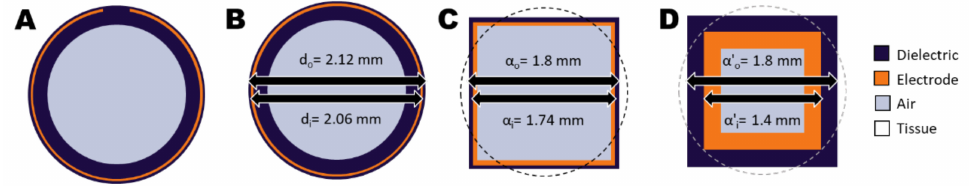
Figure 2. Cross-sections of the ThermoBrachy applicator show the geometric simplification steps applied in this study. ( A ) The actual cross-section of the thermobrachy electrode. ( B ) The electrode can be closely approximated by a cylindrical electrode equivalent. ( C ) The cylindrical applicator can be closely approximated by an orthogonal equivalent with equal outer surfaces for the electrode and dielectric layers. ( D ) The dimensions of the orthogonal layers can be adapted with a simultaneous adaptation of the dielectric properties of the materials. In all subfigures, tissue is represented by the background color (white) and surrounds the